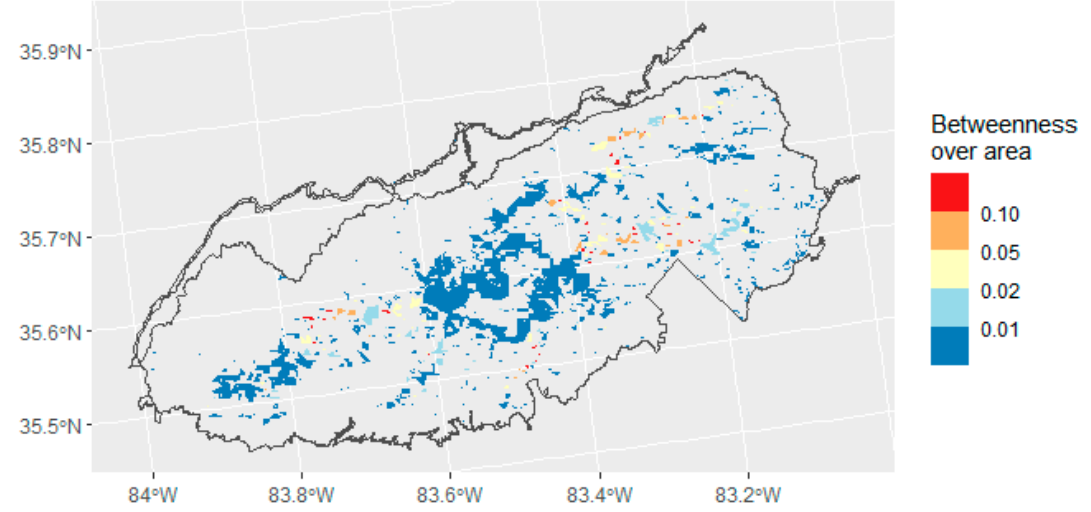
Figure 9. Betweenness centrality divided by area (in square meters) for patches dominated by SOD spreader species in the Great Smoky Mountains National Park .